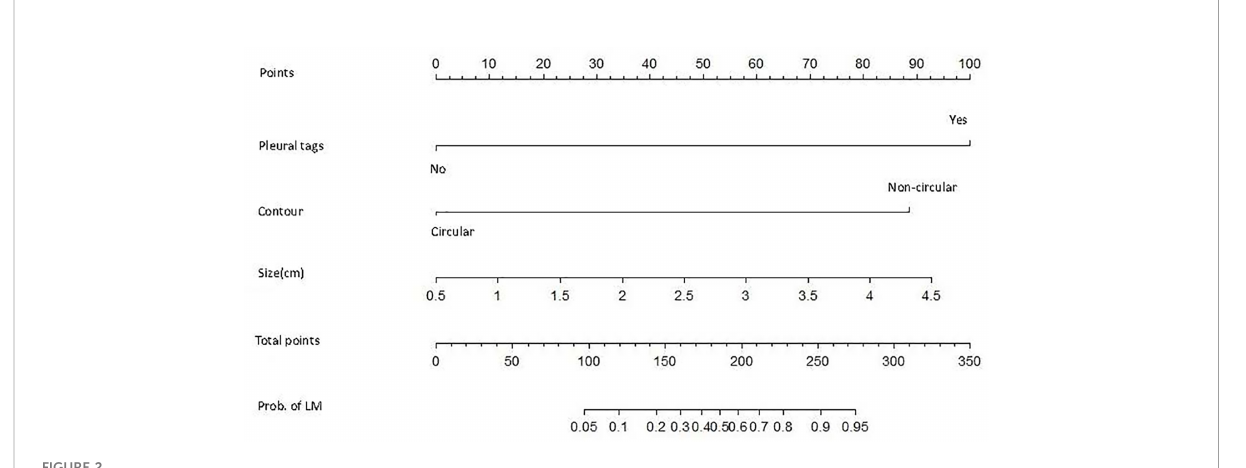
FIGURE 2 The nomograms for the diagnostic model of CRC patients.